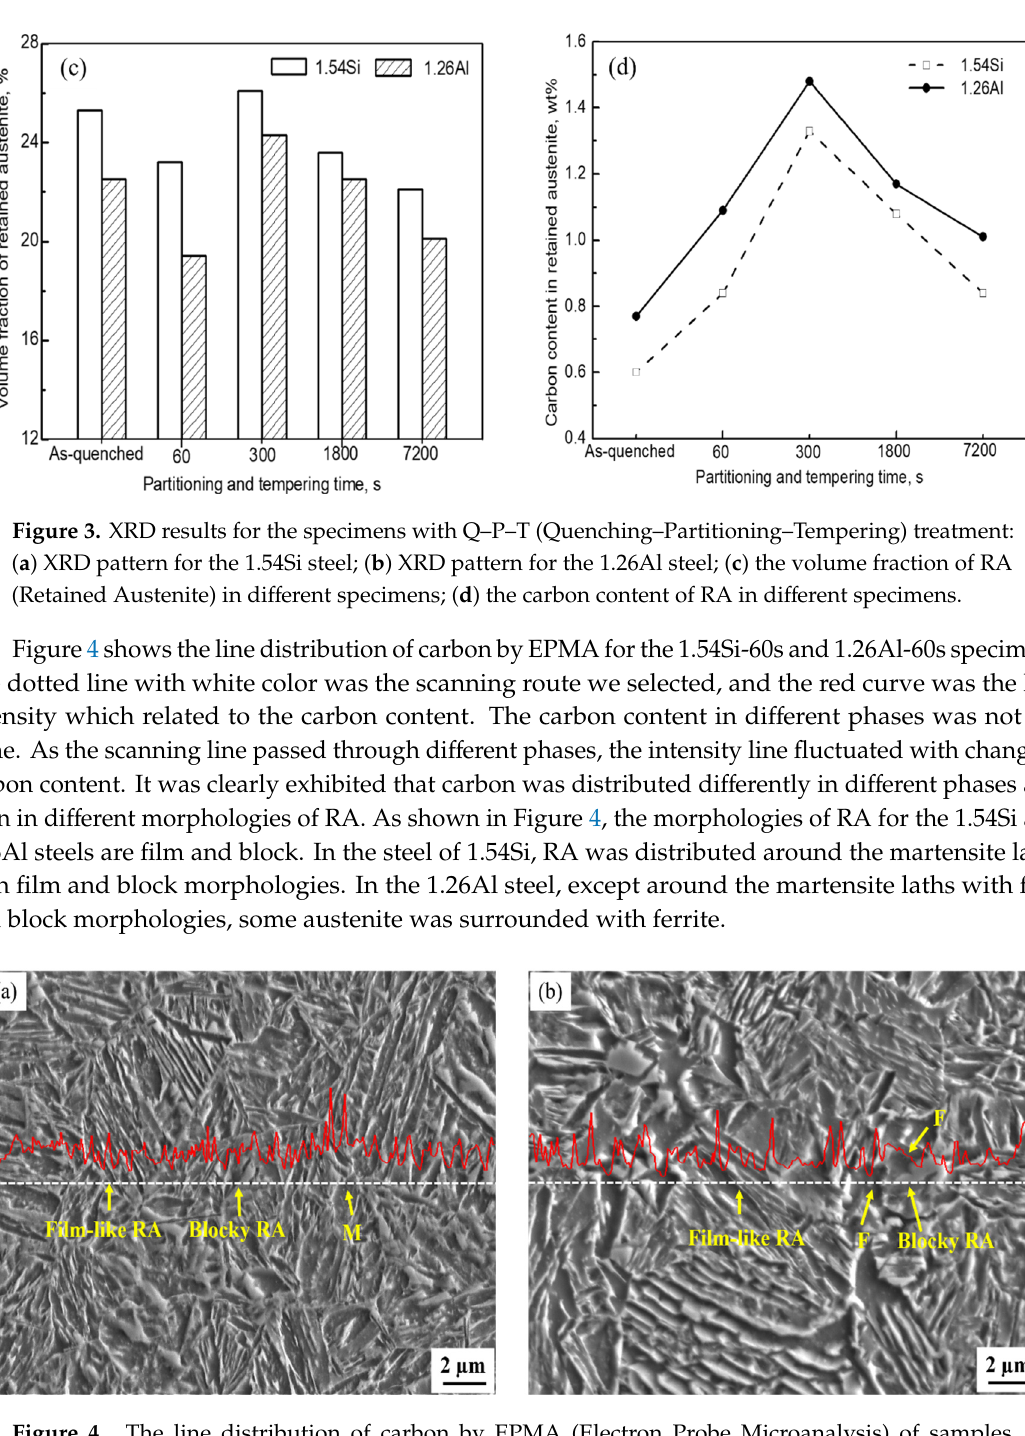
Figure 4. The line distribution of carbon by EPMA (Electron Probe Microanalysis) of samples partitioned-tempered for 60 s: ( a ) for 1.54Si steel and ( b ) for 1.26Al steel.